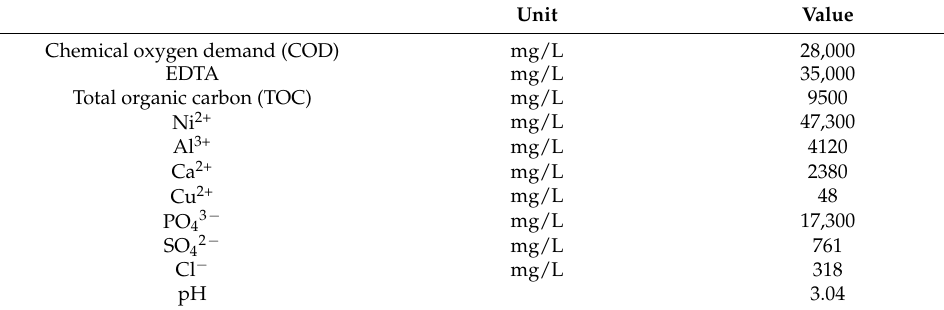
Table 1. Leaching solution wastewater